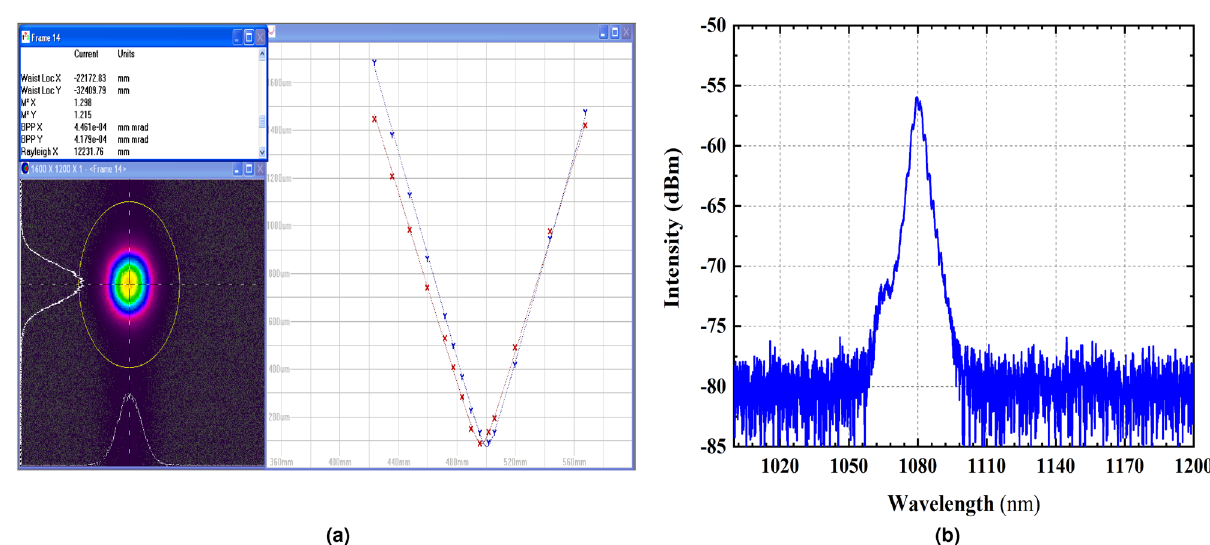
Figure 6. ( a ) The near-diffraction-limited beam quality of the bidirectional-pumping configuration which M 2 ≈ 1.3 at output power of 3.02 kW indicates the mitigation of TMI. ( b ) spectrum of the fiber laser at 3.02 kW output